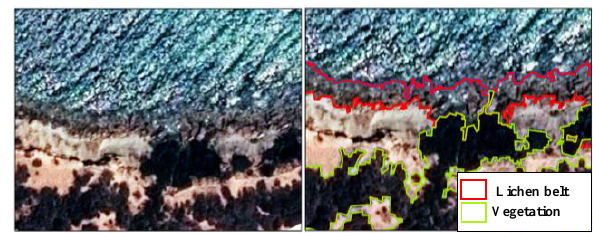
Figure 7 . The misclassification and confusion between Lichen and Vegetation